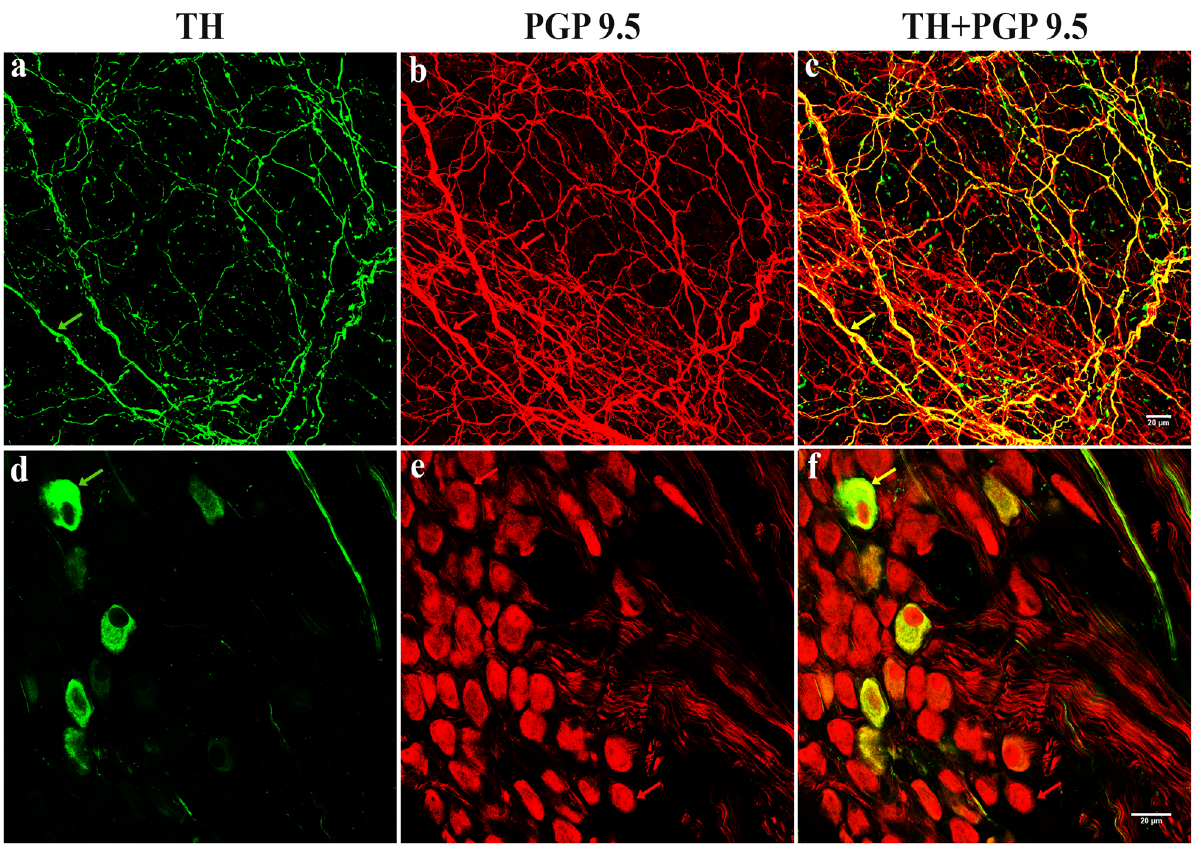
Figure 5. TH-IR and PGP 9.5-IR neurons and axons in the ICG in the atria: Double-labeled. All TH-IR axons and neurons were also positive for PGP 9.5. A few TH-IR neurons were present. ICG intrinsic cardiac ganglia, PGP 9.5 protein gene product 9.5. Arrows indicate the axons and neurons that were dual labeled with TH and PGP